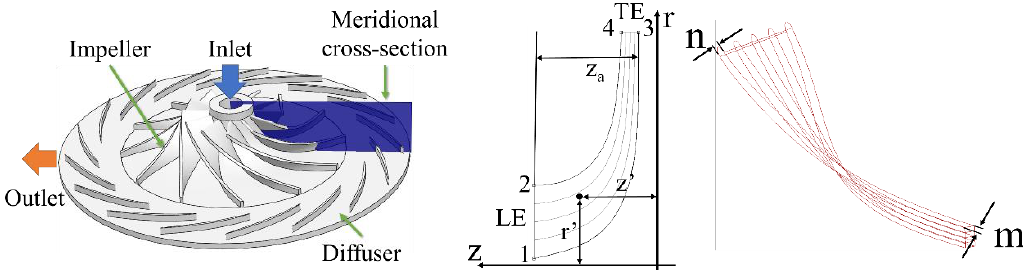
Figure 1. Geometric design diagram of the impeller blade.